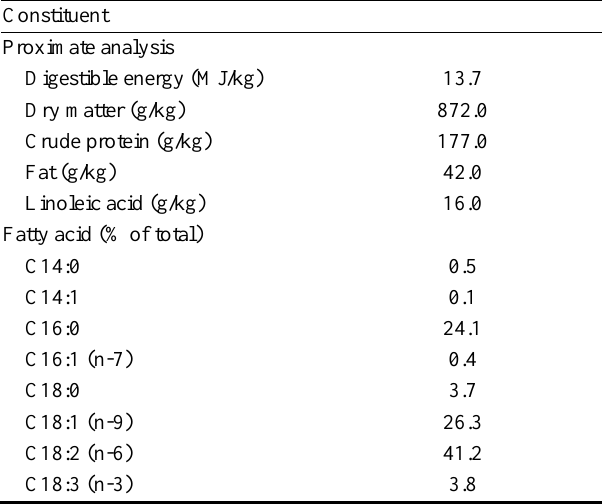
Table 2. Proximate analysis and fatty acid composition of the standard